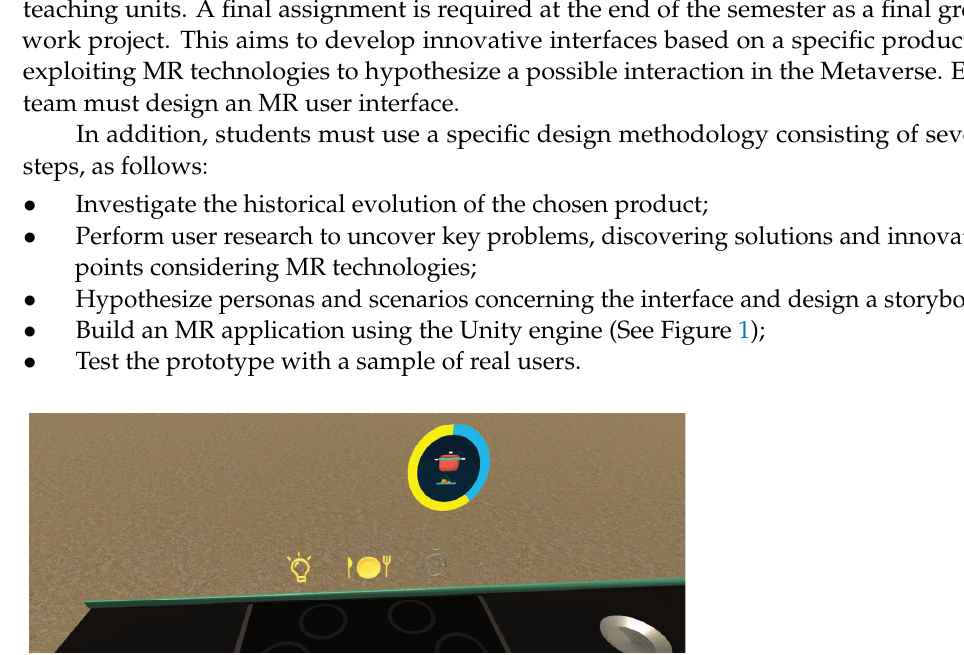
Figure 1. A detail of one of the final MR interfaces related to a kitchen hob. The interface was created using the Unity 3D engine with a canvas containing animations. The interface icons communicate the remaining cooking time and other information related to the preparation of dishes in real time.